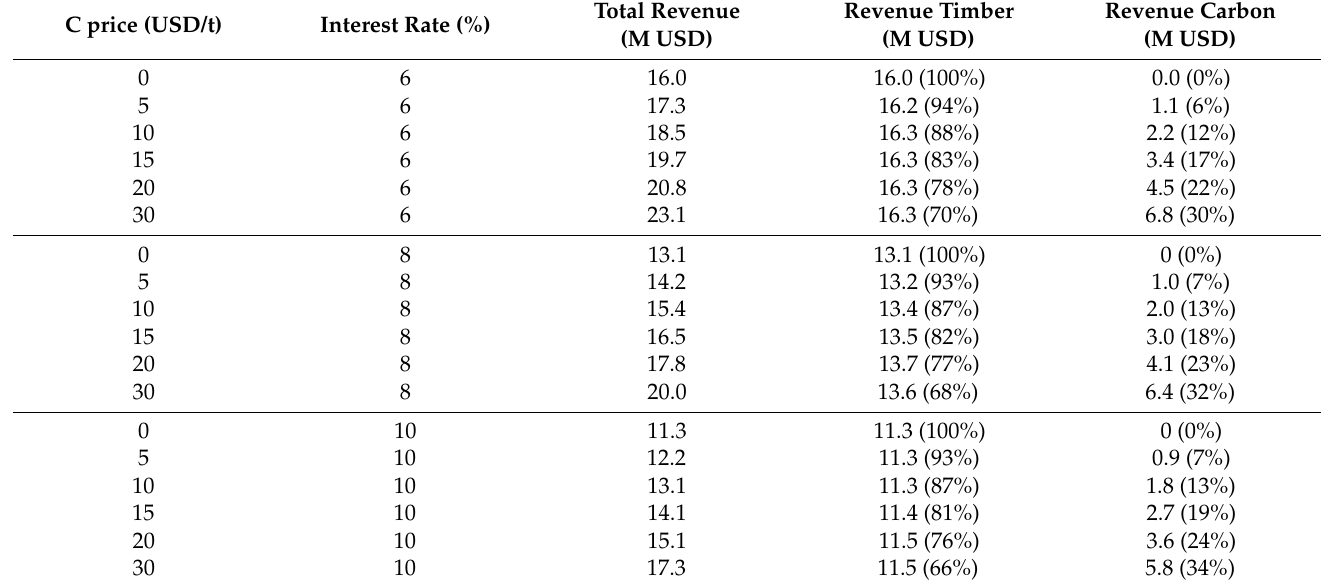
Table 3. Effect of C and timber price, and IR on revenue. Values (in millions of dollars) are calculated for a timber price of 65 USD m − 3 and considering 50% of C released at the harvest time. In parenthesis, it is the percentage of total revenue associated with timber and